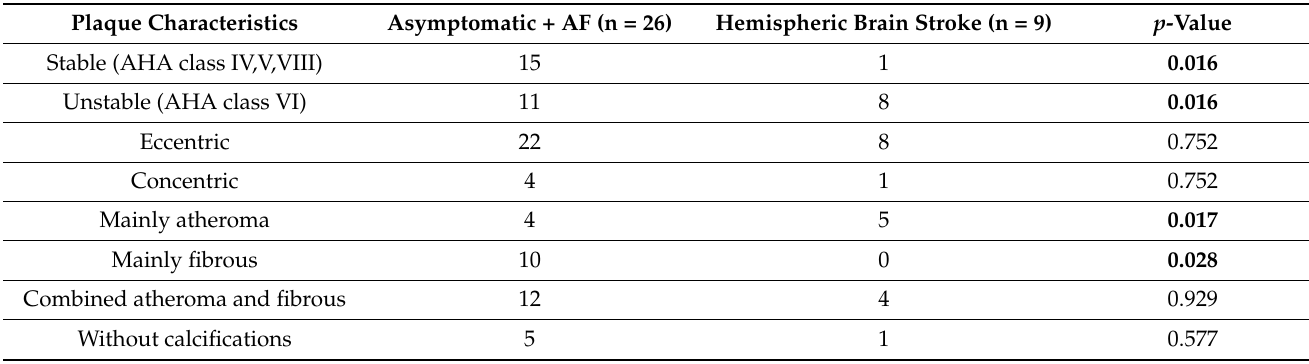
Table 3. Histological features and AHA classification of carotid plaques. Asymptomatic + AF group contains patients presented with no symptoms or with AF within the previous 6 months. The hemispheric brain stroke group consists of patients who presented with TIA or brain stroke within the previous 6 months. p -value of statistical significance is